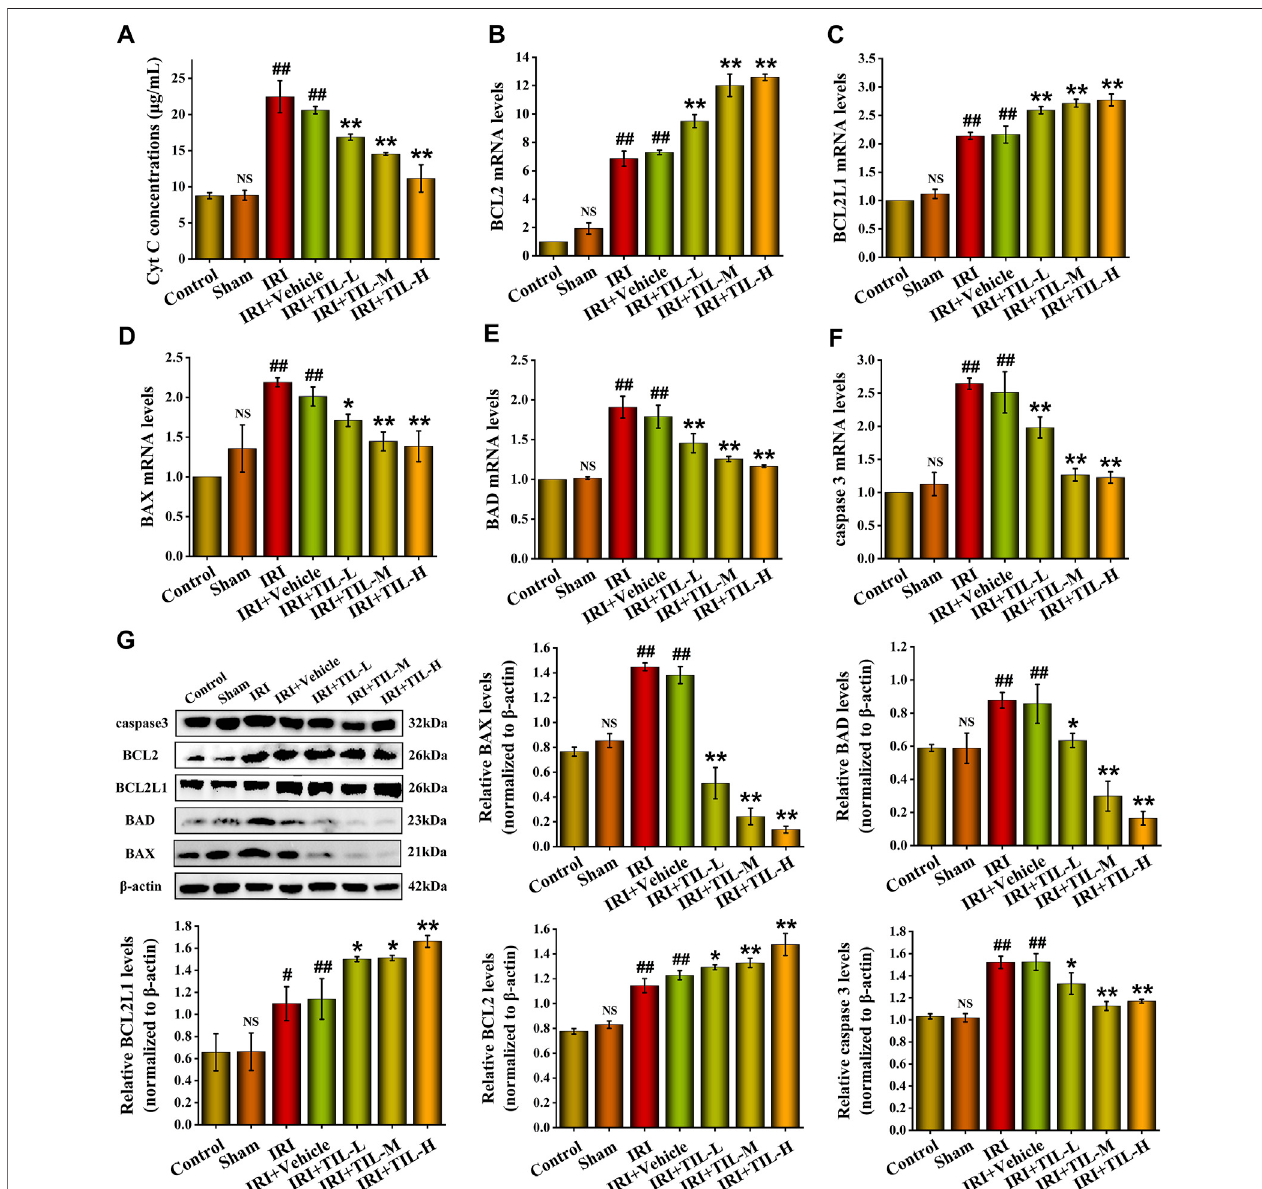
FIGURE 4 | Tilianin reduced apoptosis in mice after I/R-Induced AKI. (A) Concentrations of Cyt C released into the cytoplasm from different groups, as indicated. (B,C) Relative mRNA levels of anti-apoptotic genes BCL2 and BCL2L1 determined by qRT-PCR in different groups, as indicated. (D – F) Relative mRNA levels of pro- apoptotic genes BAX, BAD, and caspase-3 determined by qRT-PCR in different groups, as indicated. (G) Protein expression and statistical results of apoptosis-related genes BAX, BAD, BCL2L1, BCL2, and caspase-3 in different groups, as indicated. n=3 per group. All data are shown as mean ± SD. # p < 0.05, ## p < 0.01 versus control ; NS P > 0.05 versus control ; *p < 0.05, **p < 0.01 versus